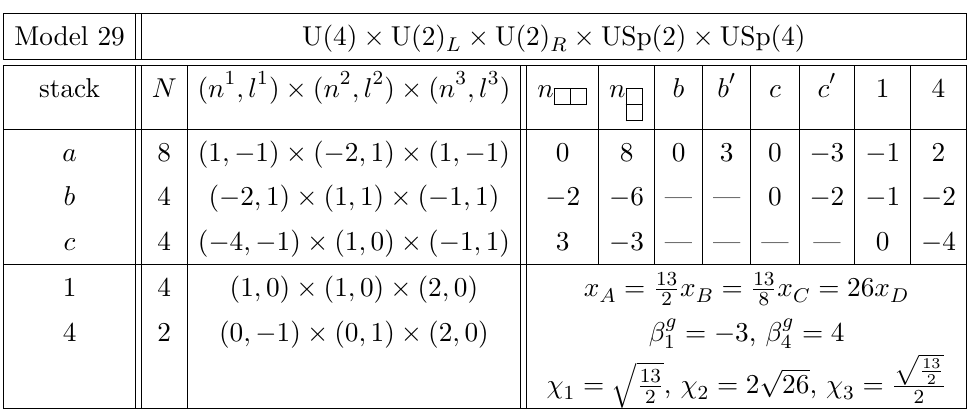
Table 36 . D6-brane configurations and intersection numbers of Model 29, and its MSSM